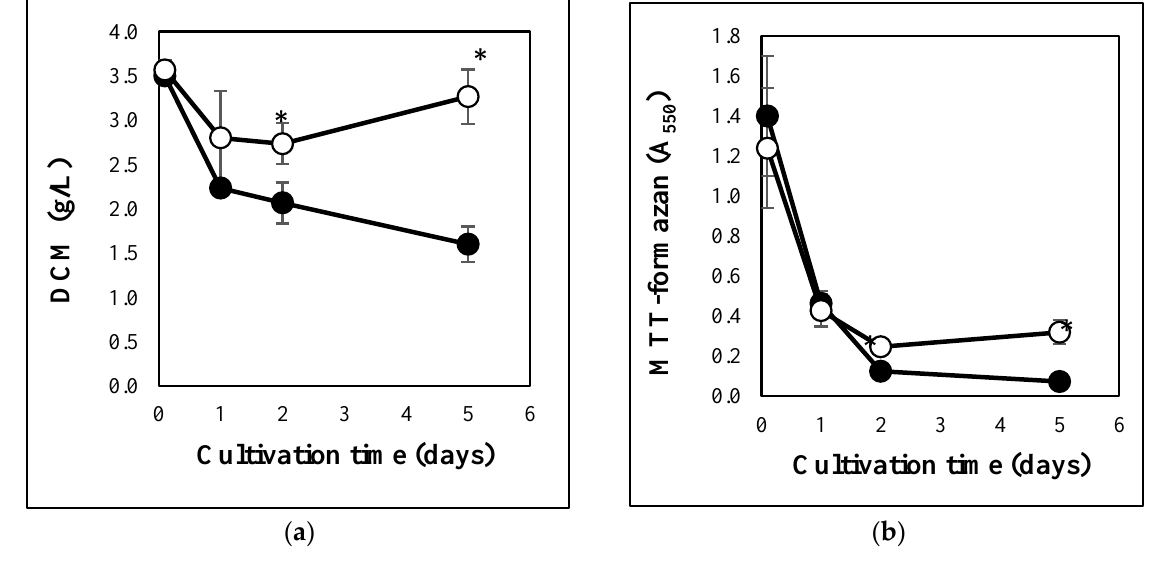
Figure 1. Changes in the DCM ( a ) and MTT reducing activity ( b ) of carbon-limited and carbon- starved A. fumigatus cultures. A. fumigatus Af293 was grown in complex mediums, and mycelia from exponentially growing phase cultures were resuspended in carbon-source-free minimal mediums either supplemented with 4 g/L casein peptone (carbon-limited cultures; ○ ) or not (carbon-starved cultures; • ). Mean ± SD calculated from three parallel experiments are presented. *—Significant differences between the mean values of the carbon-starved and carbon-limited cultures at the marked time point according to the Student’s t -test ( p < 0.05).